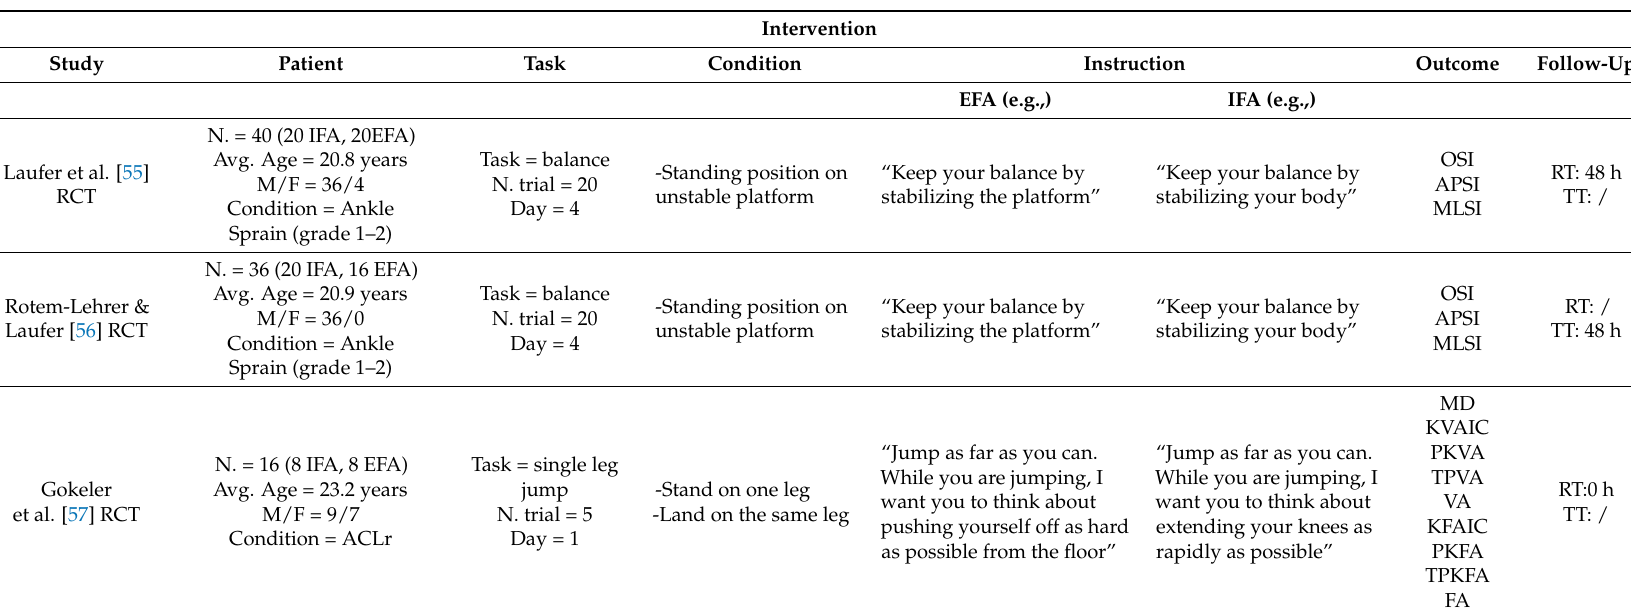
Table A4. Characteristics of the studies regarding patients with MSK